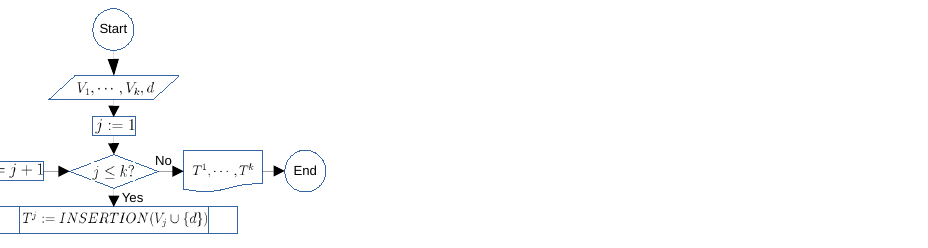
Figure 10. The last partial flowchart of the partition algorithm to obtain the subsets V j , j = 1, · · · , k .